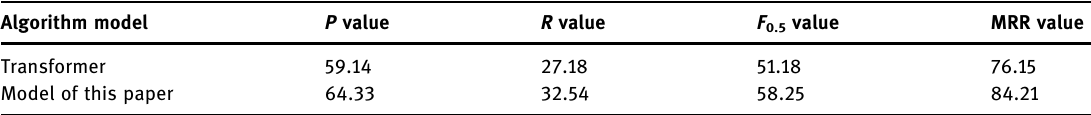
Table 2: Comparative analysis of evaluation indexes of two algorithm models for Lang - 8 test set data Algorithm